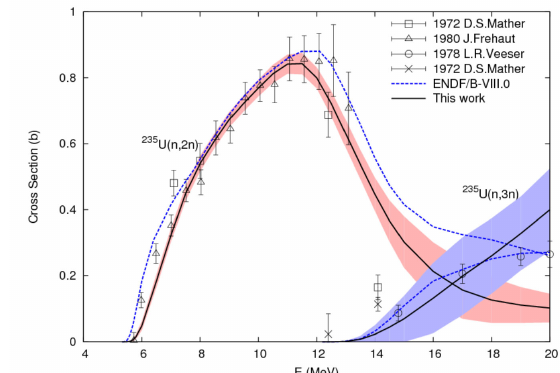
Fig.9. The comparison between the evaluated 235 U(n,2n) and (n,3n) cross sections and uncertainties and the measurements [8]